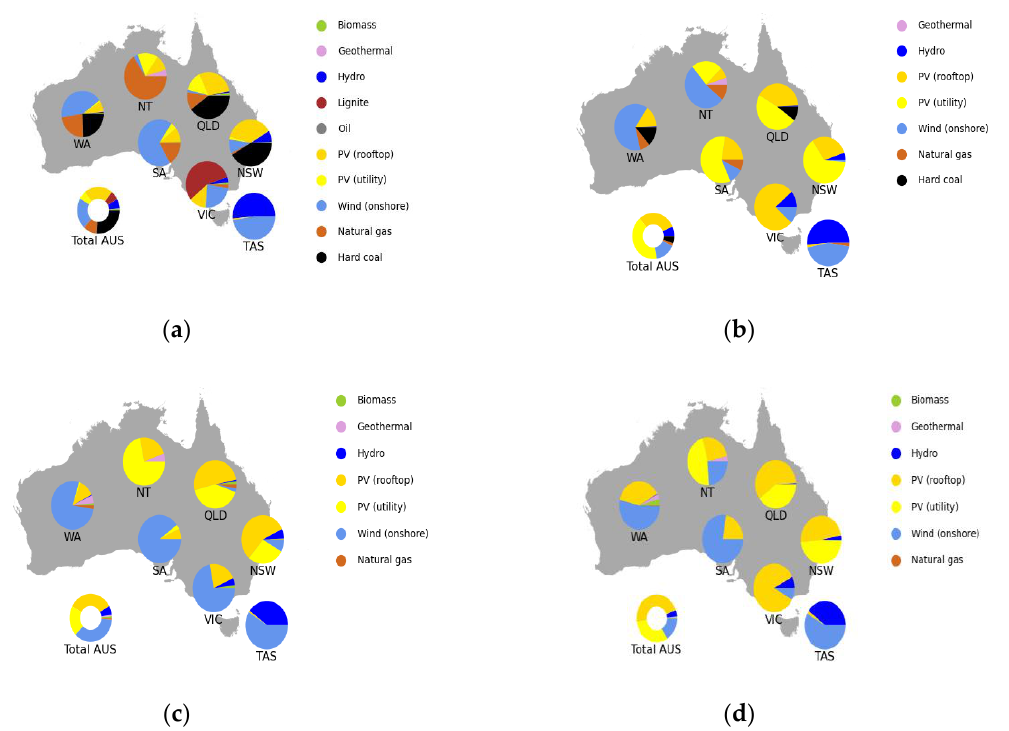
Figure 2. Regional distribution of power production mix in different scenarios and years: ( a ) LME scenario in 2030; ( b ) LME scenario in 2050; ( c ) P1.5 °C scenario in 2030; ( d ) P1.5 °C scenario in 2050.